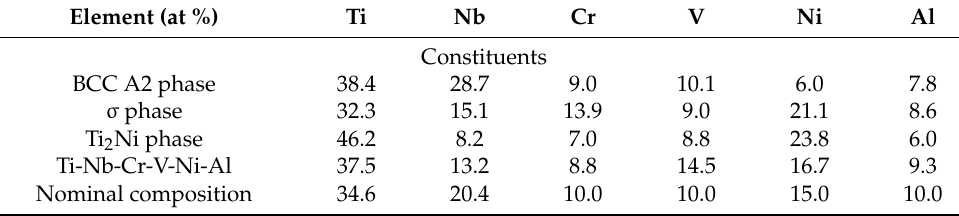
Table 4. The chemical compositions of the structure constituents for Ti-Nb-Cr-V-Ni-Al. Element (at